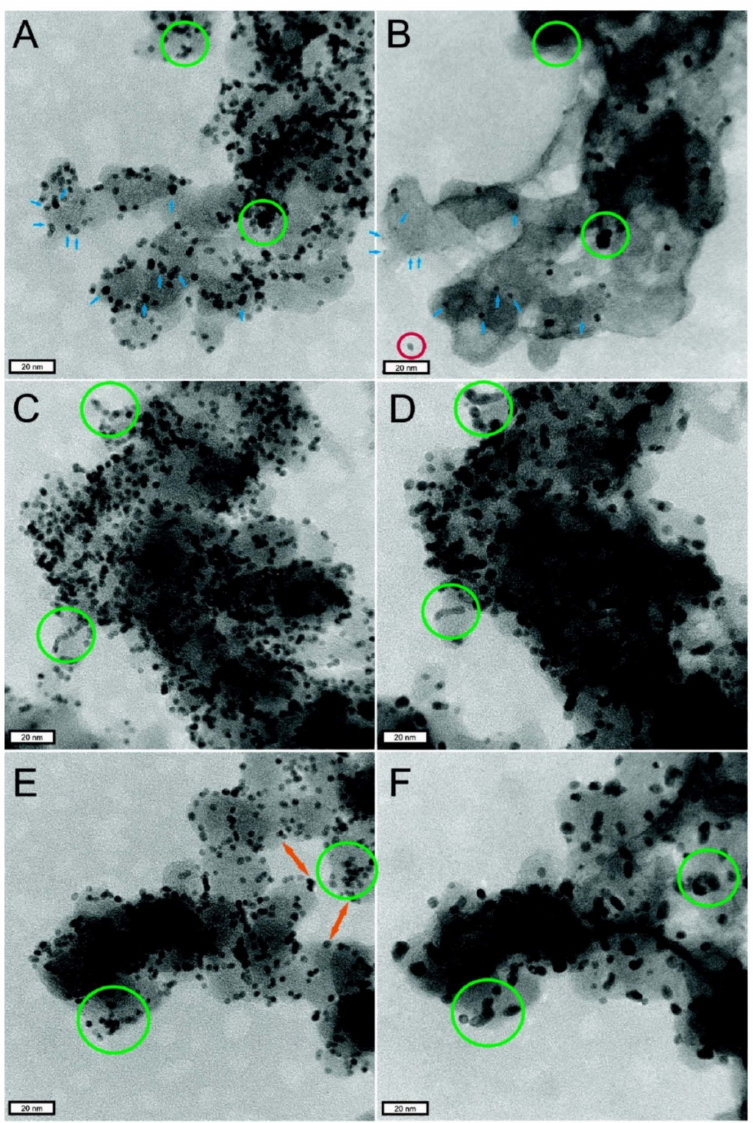
Figure 8. ILTEM images at initial ( A , C , E ) and after 3600 cycles ( B , D , F ). Green circles indicate aggregates, red circles indicate desorption Pt particles, blue arrows indicate smaller Pt particles due to dissolution, and orange arrows indicate changes in support structure [141]. Copyright © 2012 American Chemical